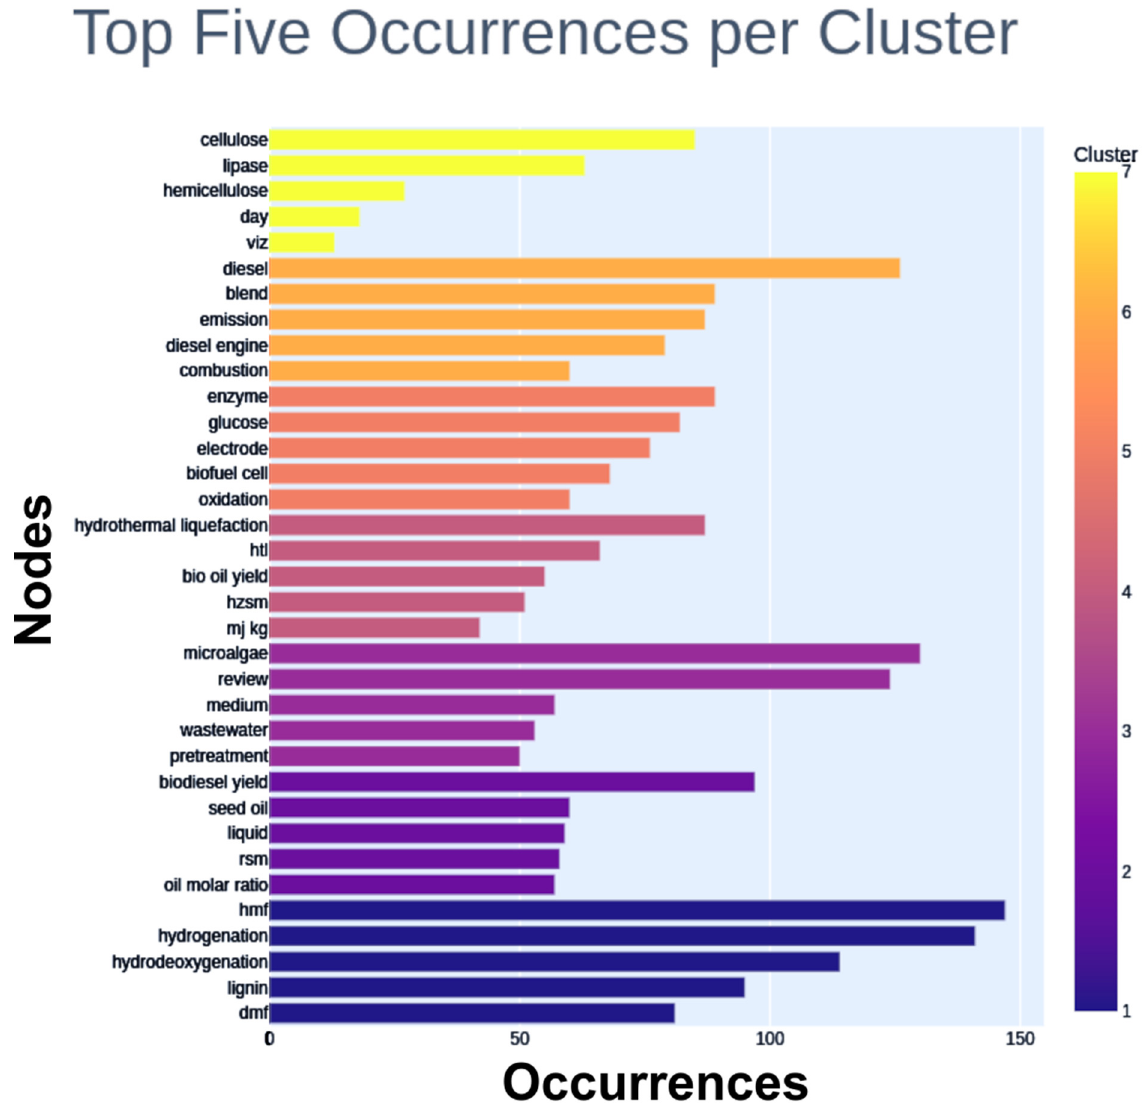
Figure 8. Top five nodes per cluster.